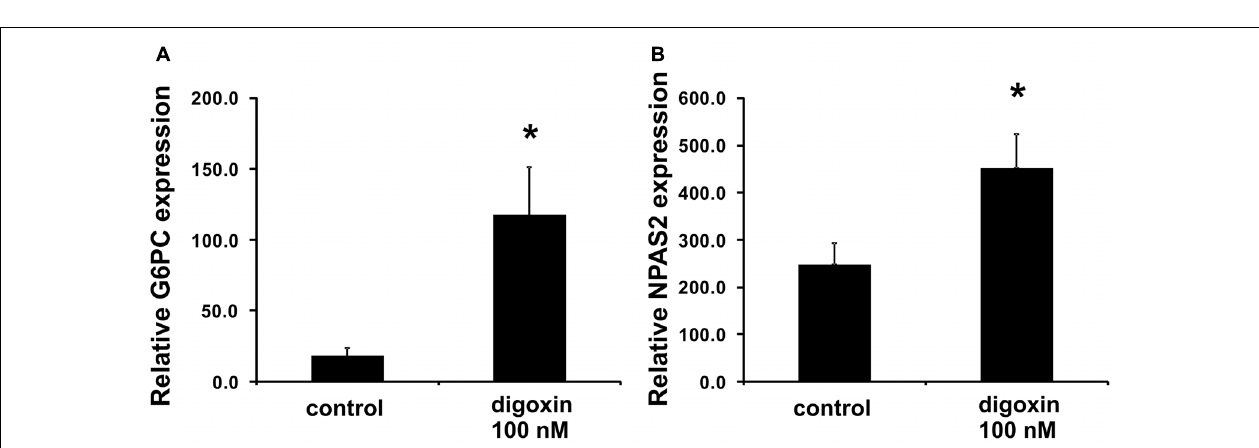
FIGURE 3 | Results of the EMSA assay. (A) ROR γ specifically binds to the considered RORE. (B) Digoxin increases binding of the protein extract to the considered RORE. Changing the brightness and contrast was applied equally across the entire images. Original scans are presented in Supplementary Materials .